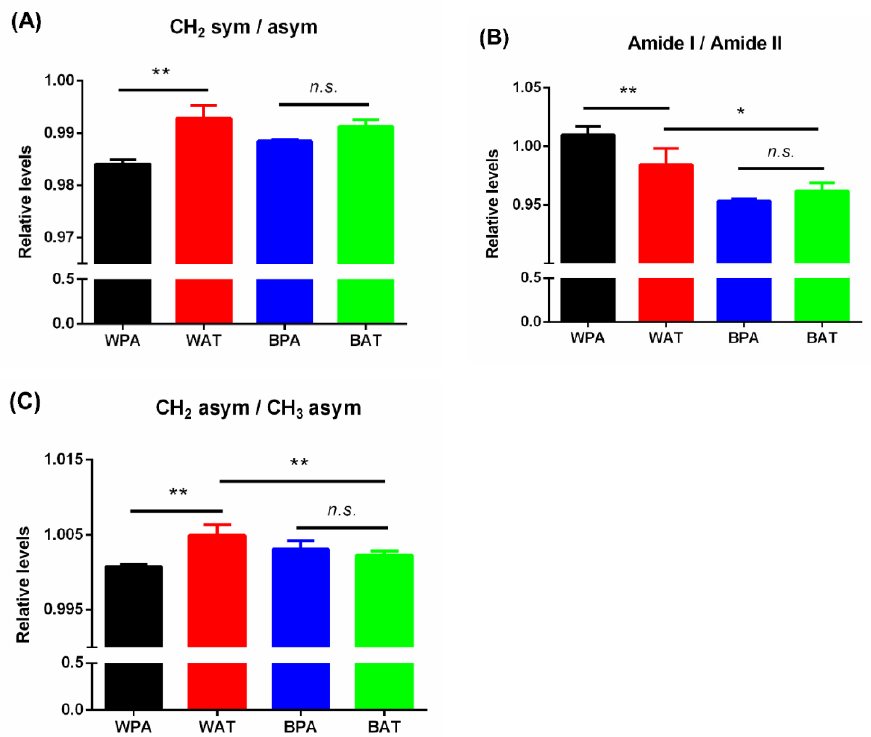
Figure 5. Analyses of FTIR spectra on different types of adipocytes—( A ) CH 2 sym/asym, ( B ) amide I/II ratio, and ( C ) CH 2 asym/CH 3 asym. Sym: symmetric stretching; asym: asymmetric stretching. * p < 0.05; ** p < 0.01; n.s. , not significance.